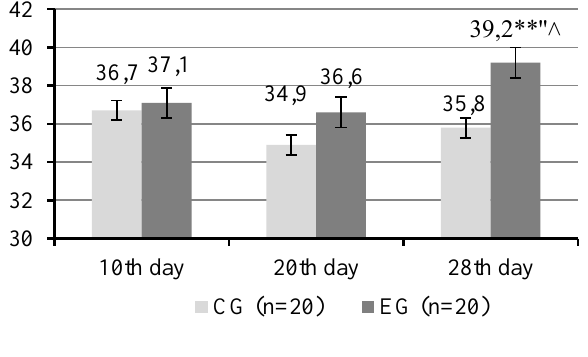
Fig. 3. Hematocrit blood value in piglets (%) During whole experiment in piglets from control and ex- perimental groups MCV was within physiological fluctua- tions (50–68 fl).